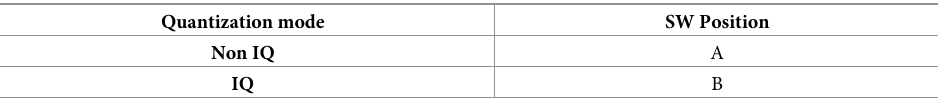
Table 1. Different quantization modes of switch SW of the proposed transcoder in